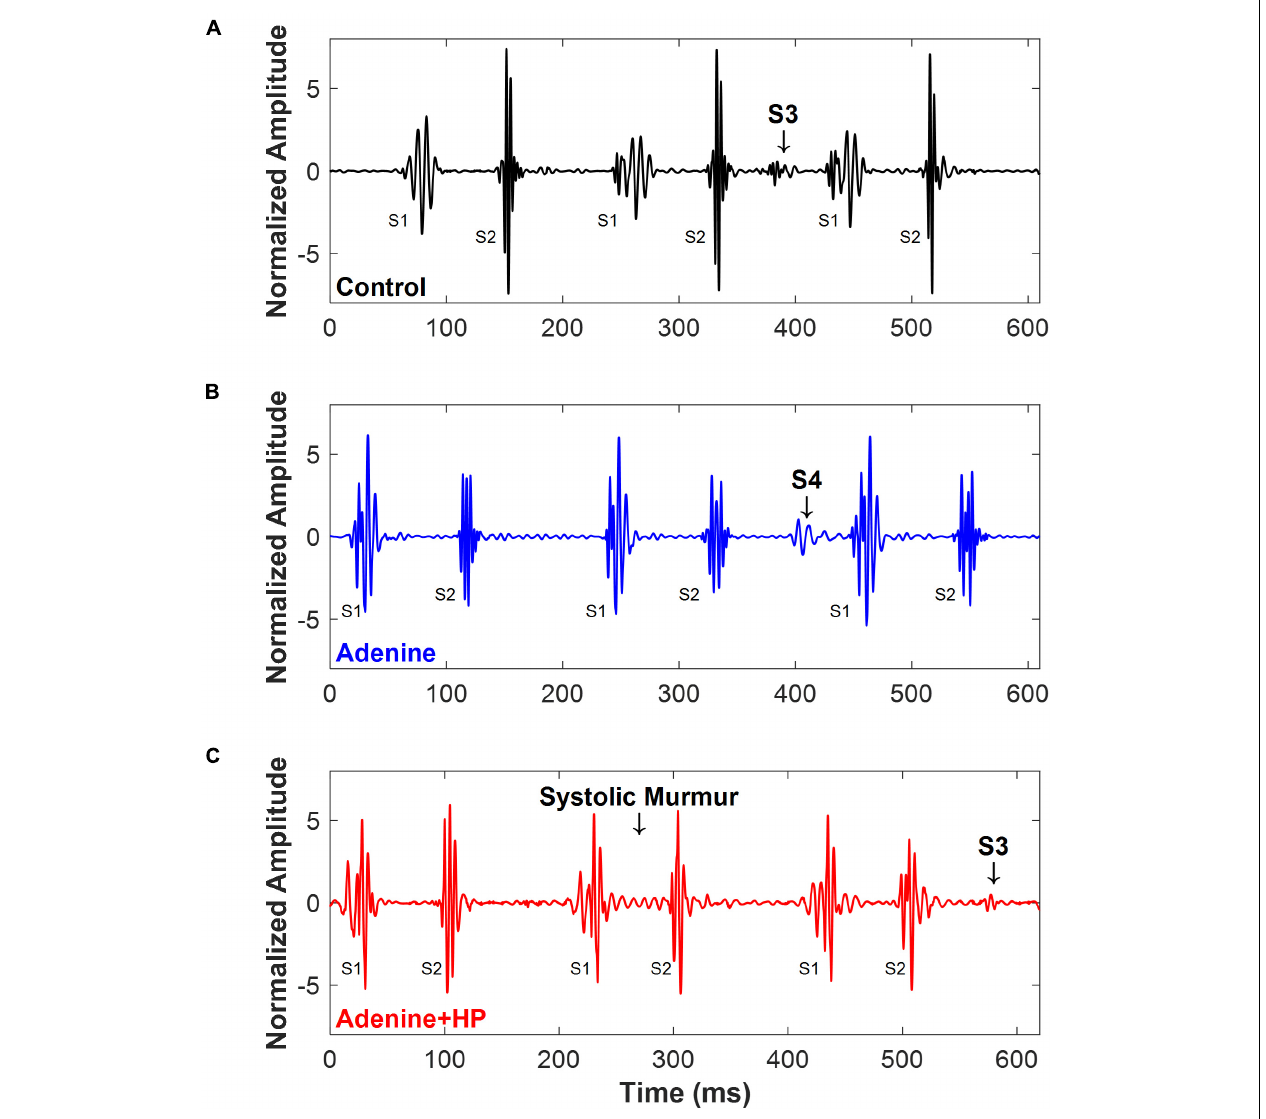
FIGURE 5 | Cardiac murmurs in mice. Examples of cardiac murmurs detected in PCG signals of mice. (A) Control mice ( n = 6/11) appeared to have an S3 sound. (B) Adenine mice ( n = 3/4) appeared to have an S4 sound. (C) Adenine + HP mice appeared to have a systolic murmur ( n = 7/9) and an S3 sound ( n =